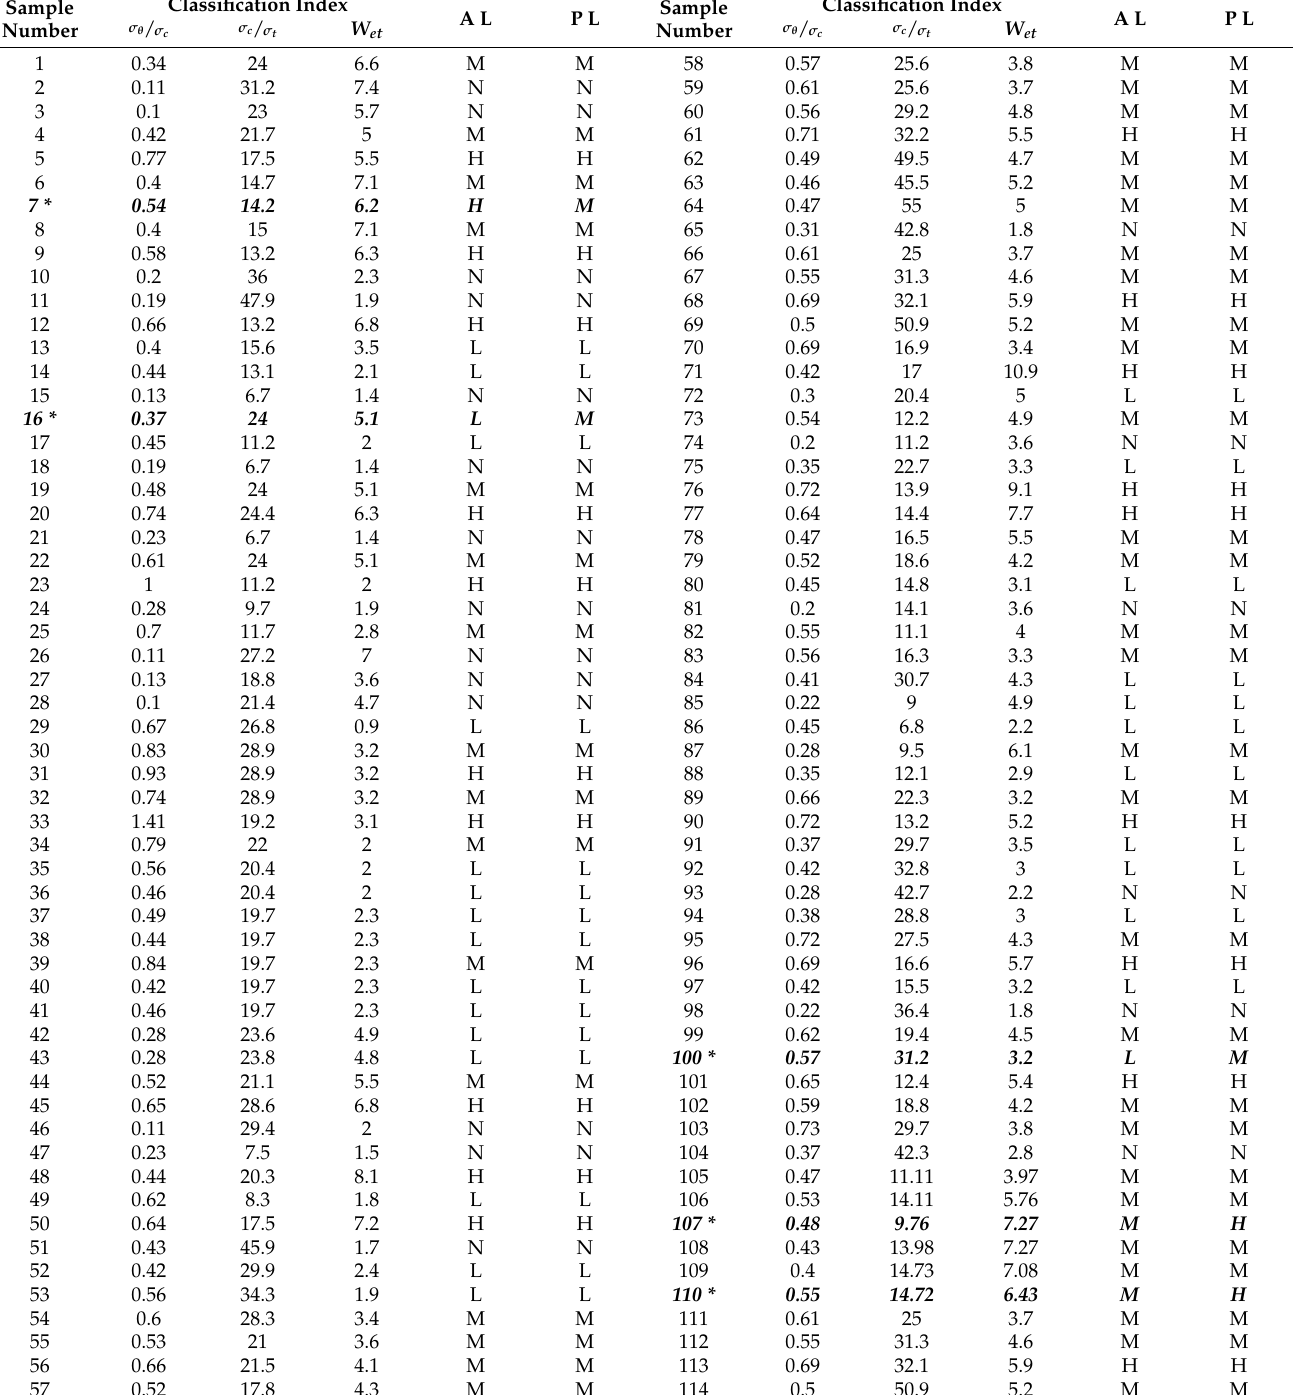
Table 2. Rock burst sample data and classification prediction